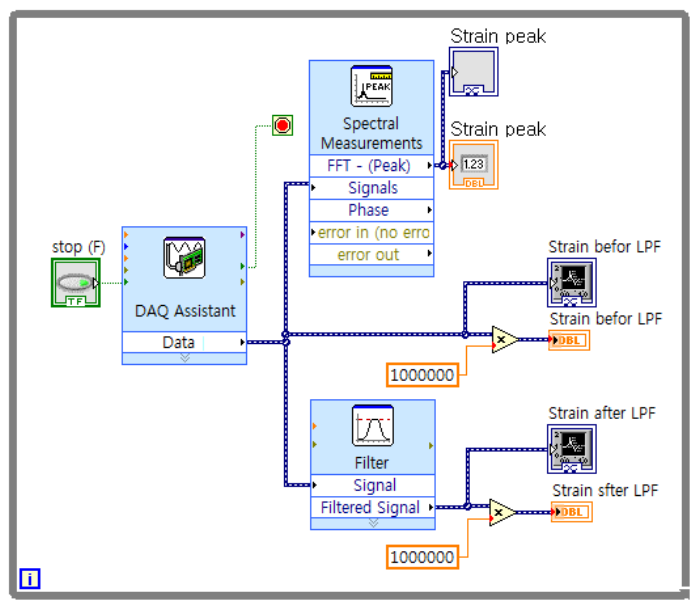
Figure 12. Experimental equipment.